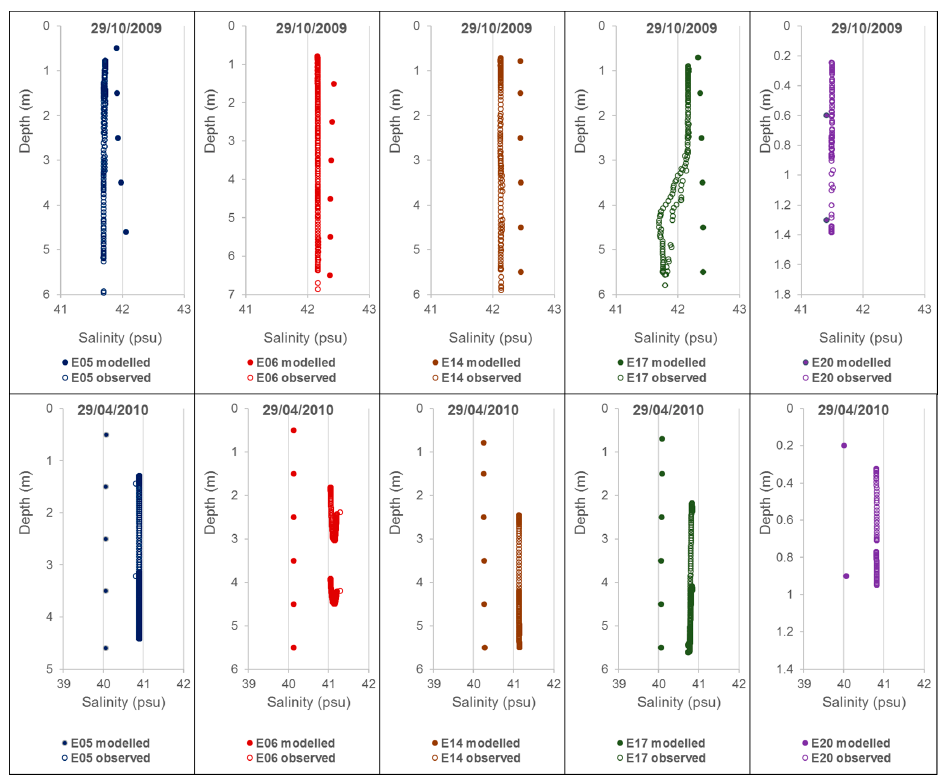
Figure 3. Modelled and observed vertical profiles of salinity on 29 October 2009 and 29 April 2010.